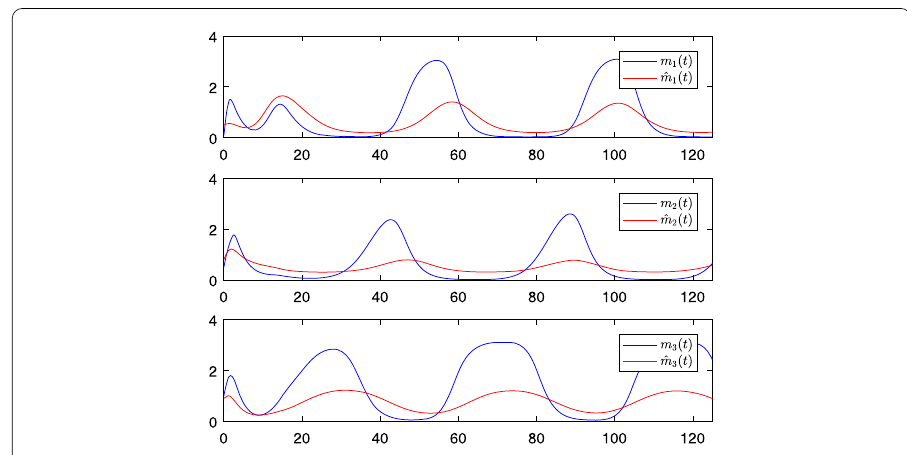
Figure 7 Time response of proteins p i ( t ) and ˆ p i ( t ), i = 1,2,3